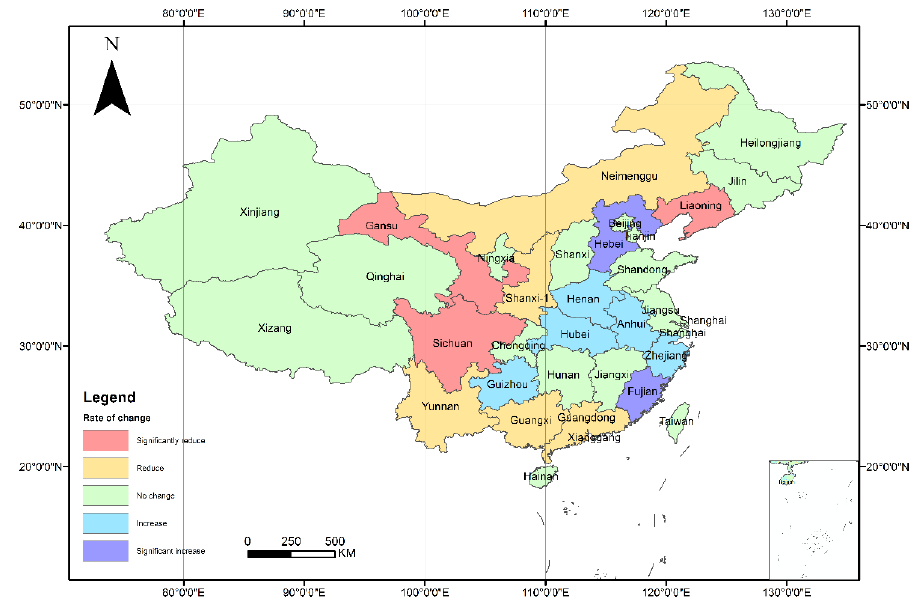
Figure 5. Changing rate of death toll of each province in 2016 compared with the 5-YA.